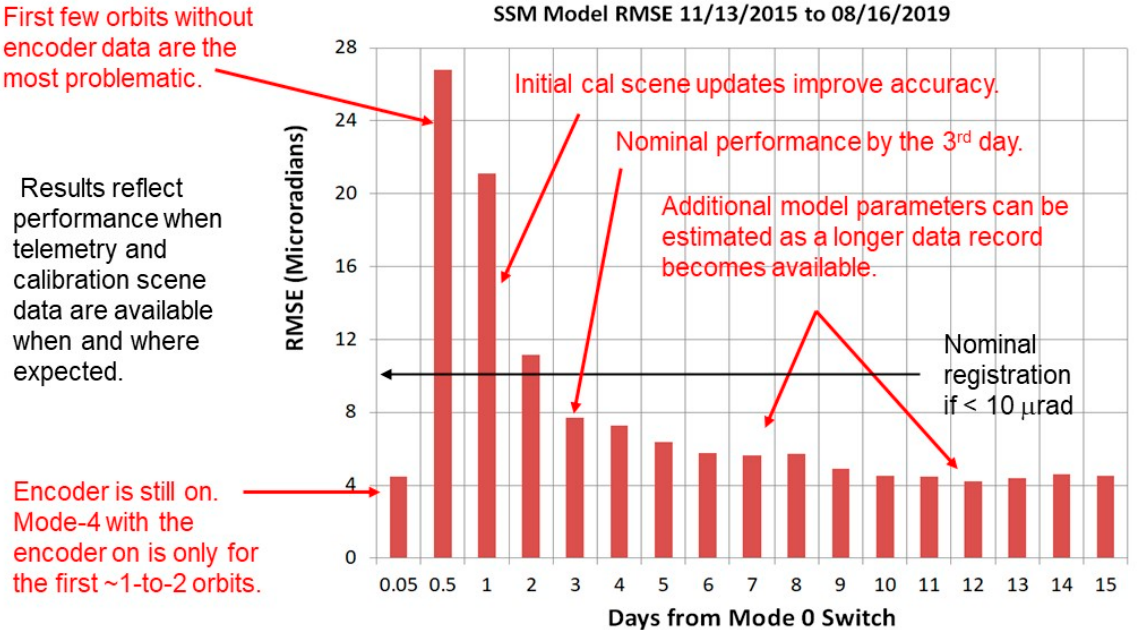
Figure 7. Bar graph shows the predicted accuracy of the TIRS-to-OLI alignment by the number of days from the start of an event. Accuracy is poorest at the beginning of the event when the mirror movement is the greatest and stabilizes the farther within an event the model transpires.